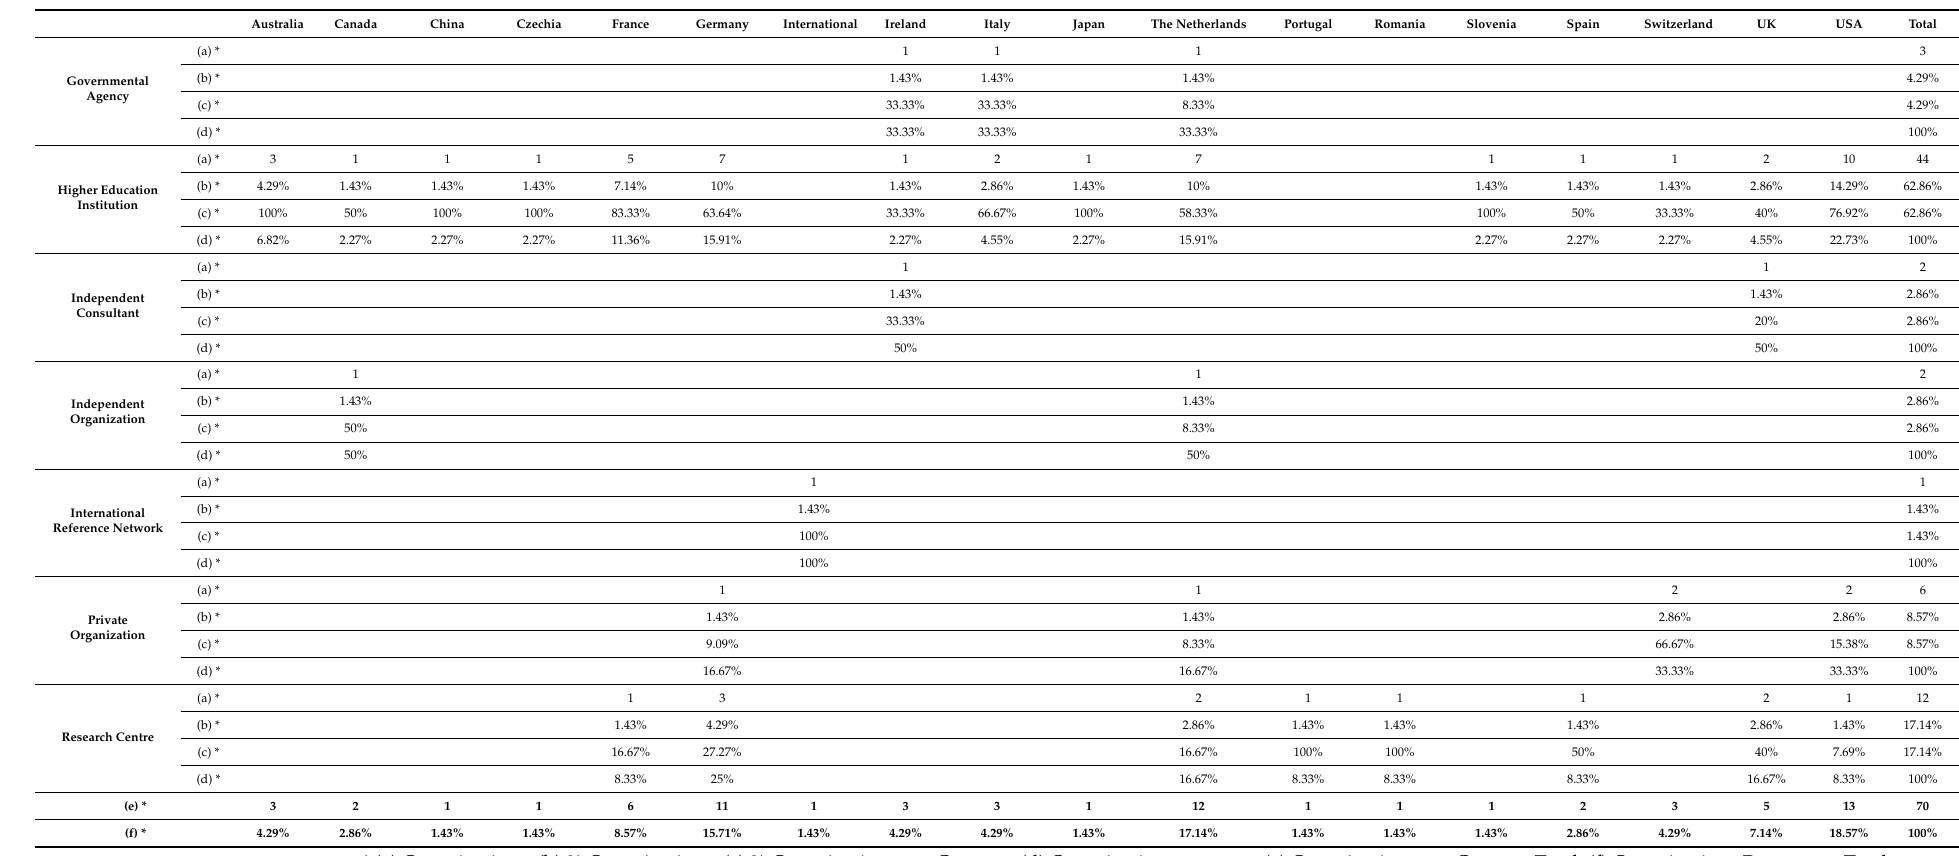
Table A5. Entities by type and